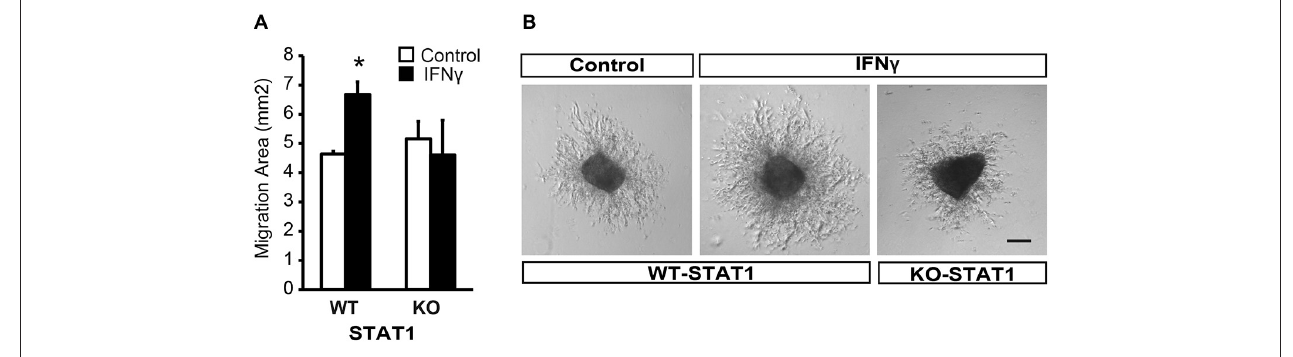
showing the ratio of migration area of proximal (P) vs. distal(D) regions of the explants, in WT and KO samples, in the presence of IFN γ ( n = 5). Scale bars = 100 µ m. Data are represented as mean ± SEM. * p ≤